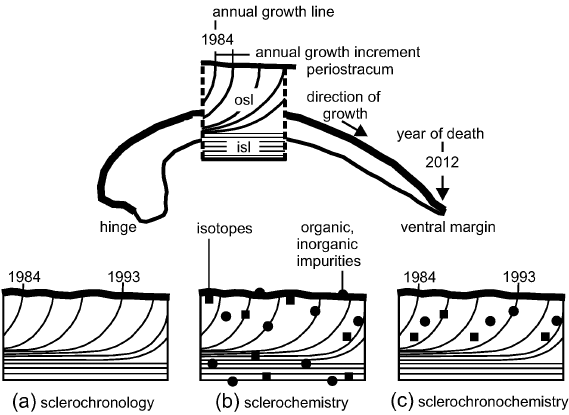
Fig. 1. Schematic cross section of a bivalve shell with block schemes showing (a) sclerochronological, (b) sclerochemical and (c) sclerochronochemical approaches. Shell layers: outer shell layer (osl) and inner shell layer